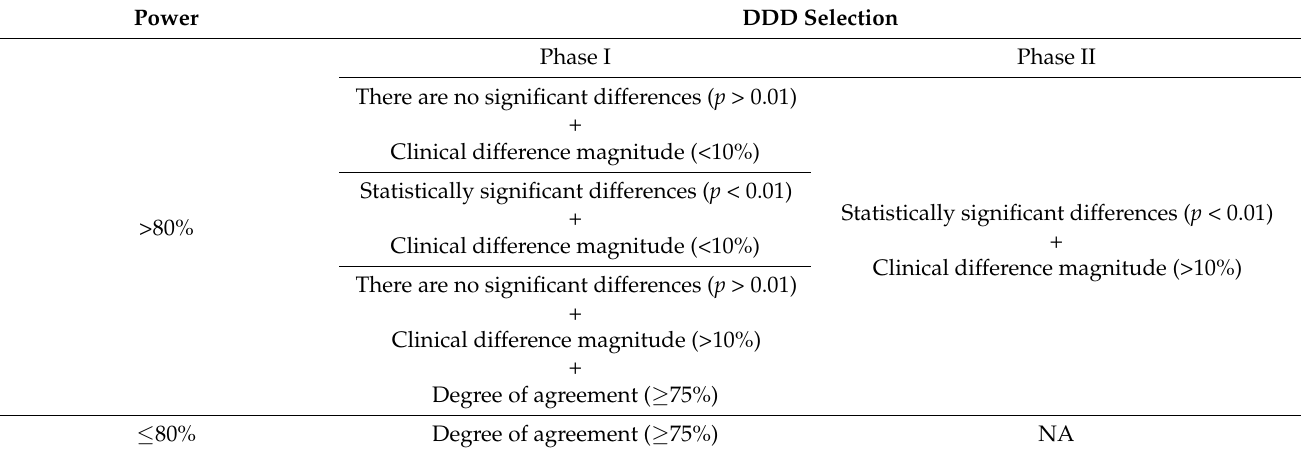
Table 1. DDD selection